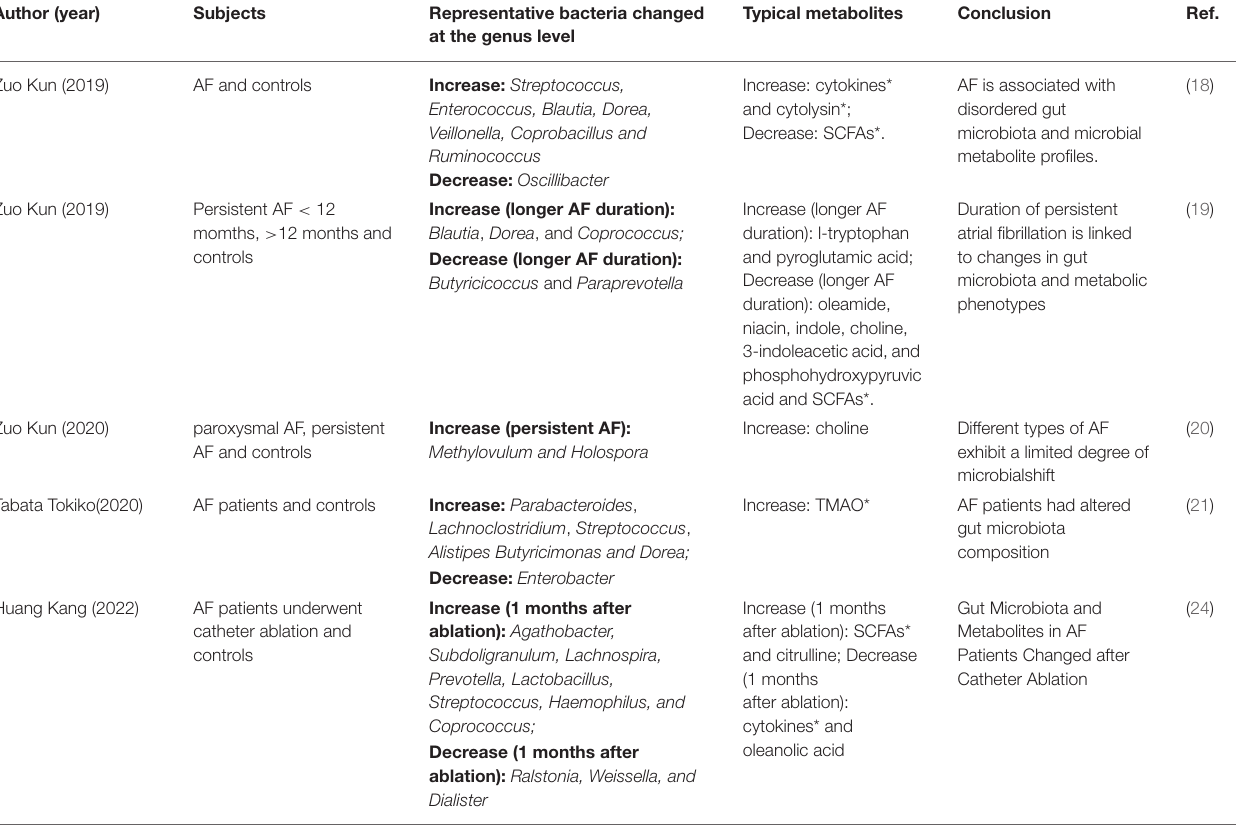
TABLE 1 | Representative gut microbiome and metabolites for AF in different